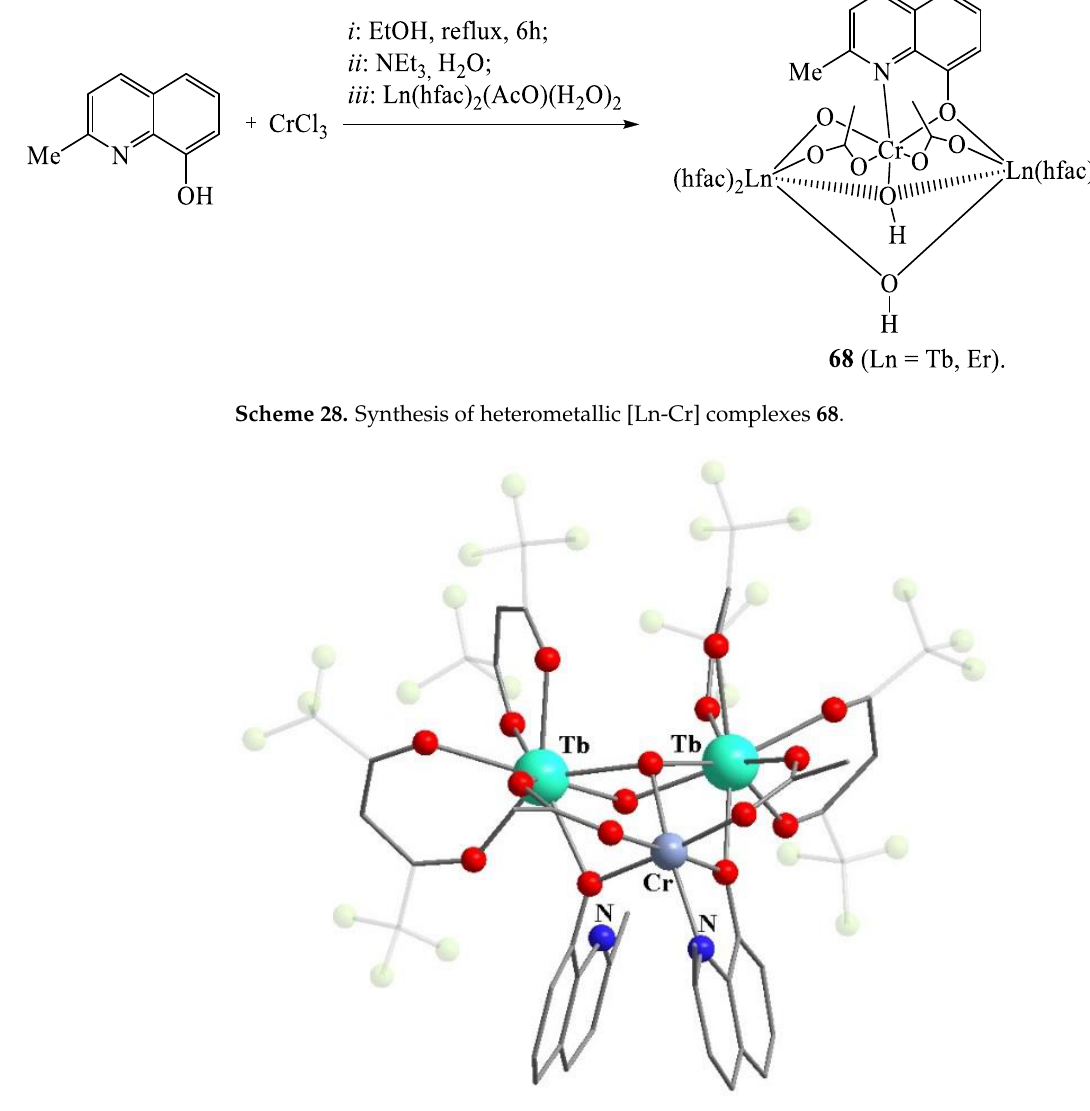
Figure 35. Molecular structure of 68 [108]. CF 3 groups are transparent for clarity. The cif has been retrieved from CCDC. CCDC number is 812496.